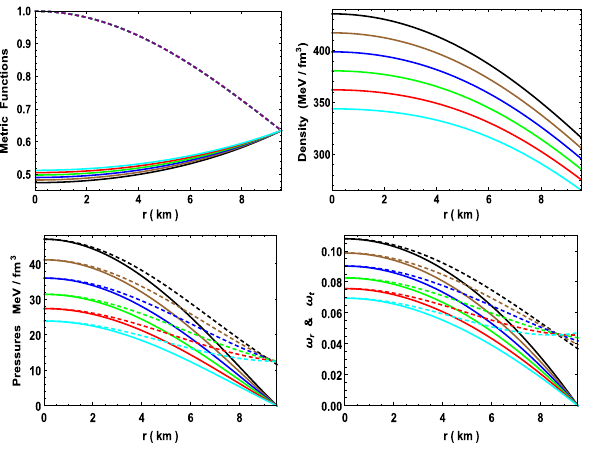
Fig. 20 Variation of anisotropy, TOV-equation ( F a − dashed, F g − small dashed, F h − solid), sound speed ( v r − solid, v t − dashed) and stability factor with radial coordinate r for 4U 1608-52 ( M = 1 . 74 M (cid:9) , R = 9 . 528 km) by taking a = 0 . 001 km − 2 and n = 3. We are using the same color notation in all the graphs from Figs. 19, 20 and 21 as β = 0 (black), 0.014 (brown), 0.028 (blue), 0.042 (green), 0.056 (red) and 0.07 (cyan)